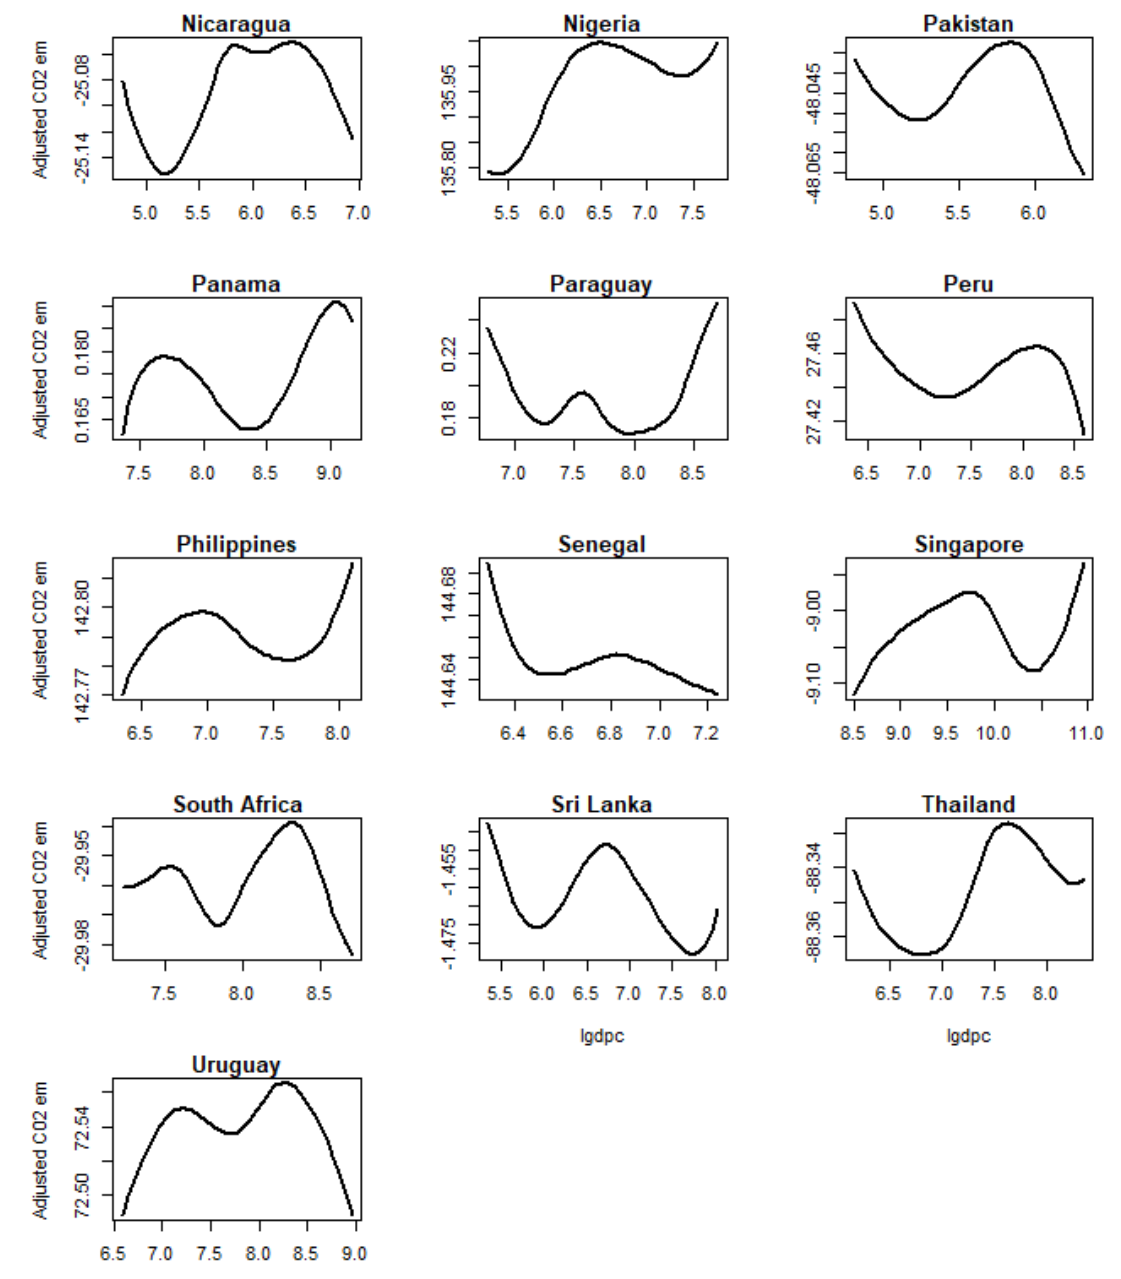
Figure 4. Nonparametric estimates of income-CO 2 emissions for the non-OCDE countries